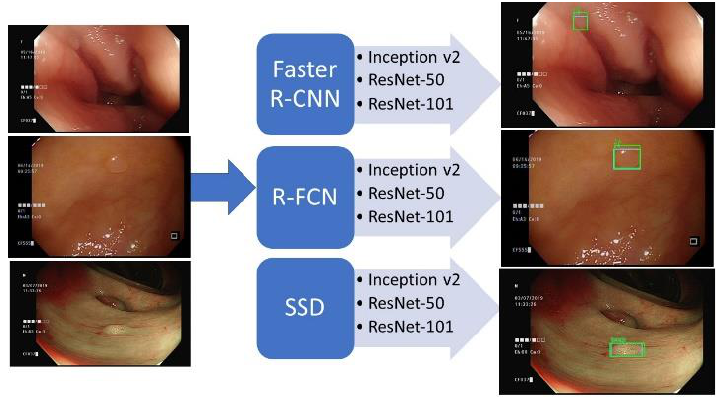
Figure 5. Polyps detection system.